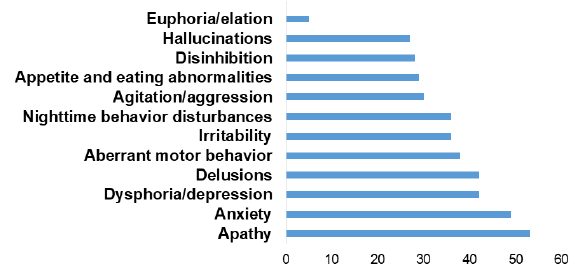
Figure 1. Frequency of patients with neuropsychiatric symptoms